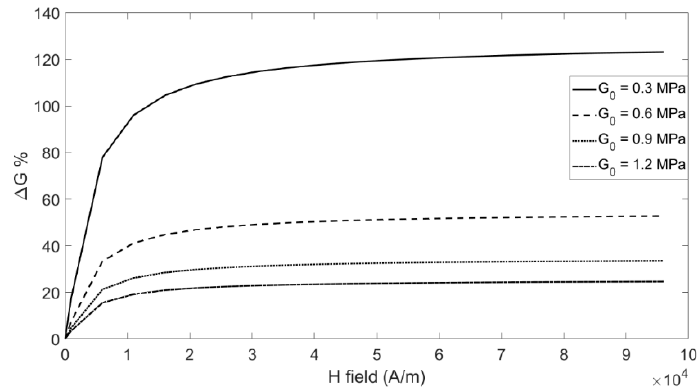
Figure 2. Magneto-rheological (MR) effect for some values of matrix moduli G 0 .